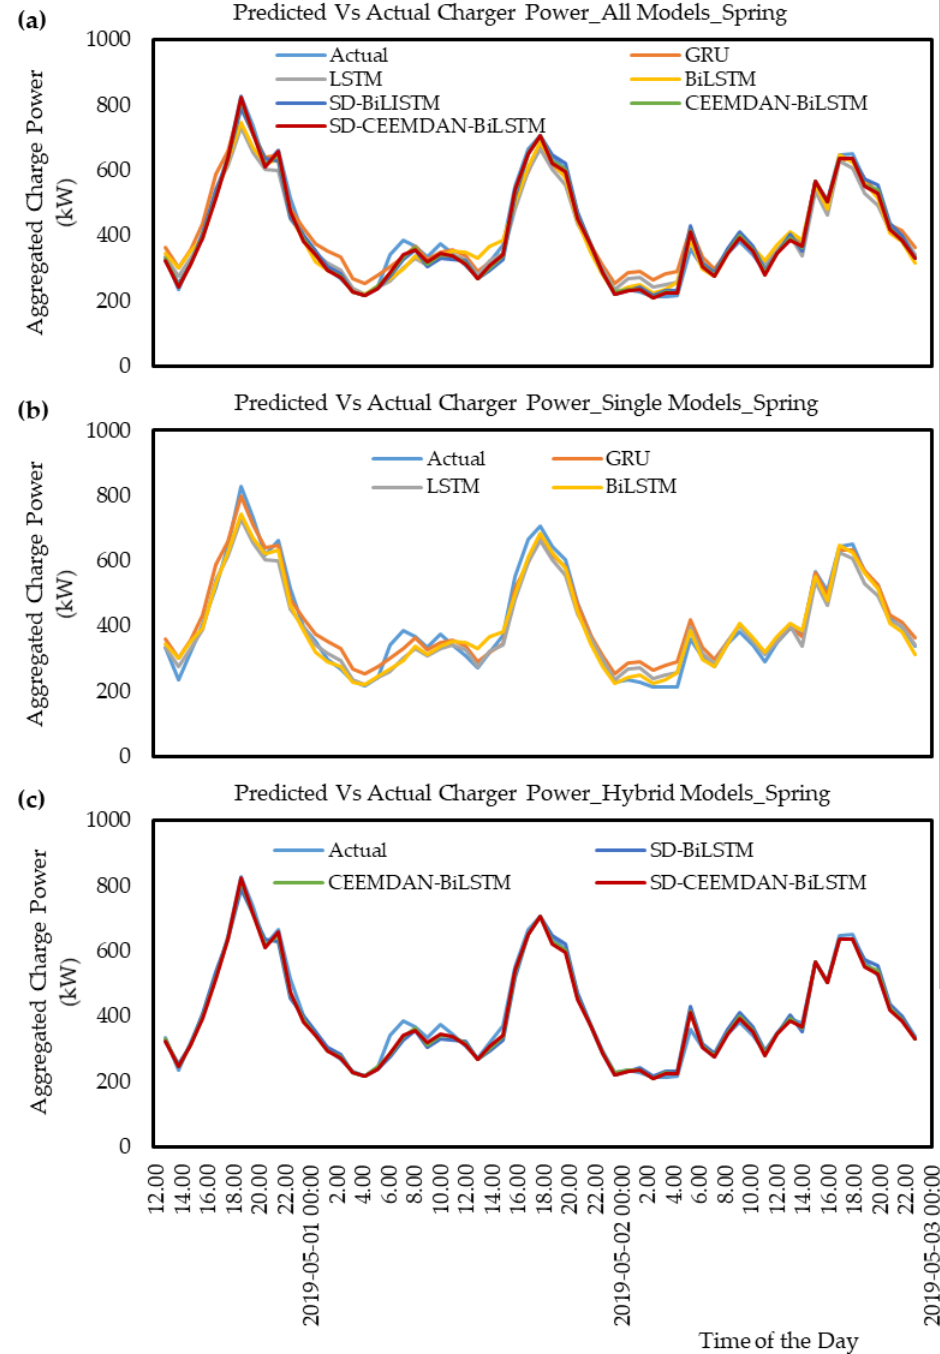
Figure 7. Predictions and actual aggregated charge power during the three-day-ahead prediction period in spring for ( a ) all prediction models, ( b ) single prediction model, ( c ) hybrid prediction model. Tables 3 and 4 compare the MAPE values for all the models by month for the one-day- ahead and the three-day ahead prediction. The training period is from 20 August 2017 to 31 December 2018, and the prediction period is from 1 January 2019 to 30 May 2019. The results indicate that the proposed model is significantly superior to the single models and other hybrid models. MAPE of the SD-CEEMDAN-BiLSTM model is the lowest among all the models. The average forecasting accuracy of the proposed model reaches 97.93% and 97.29% in the one-day-ahead and the three-day-ahead prediction,